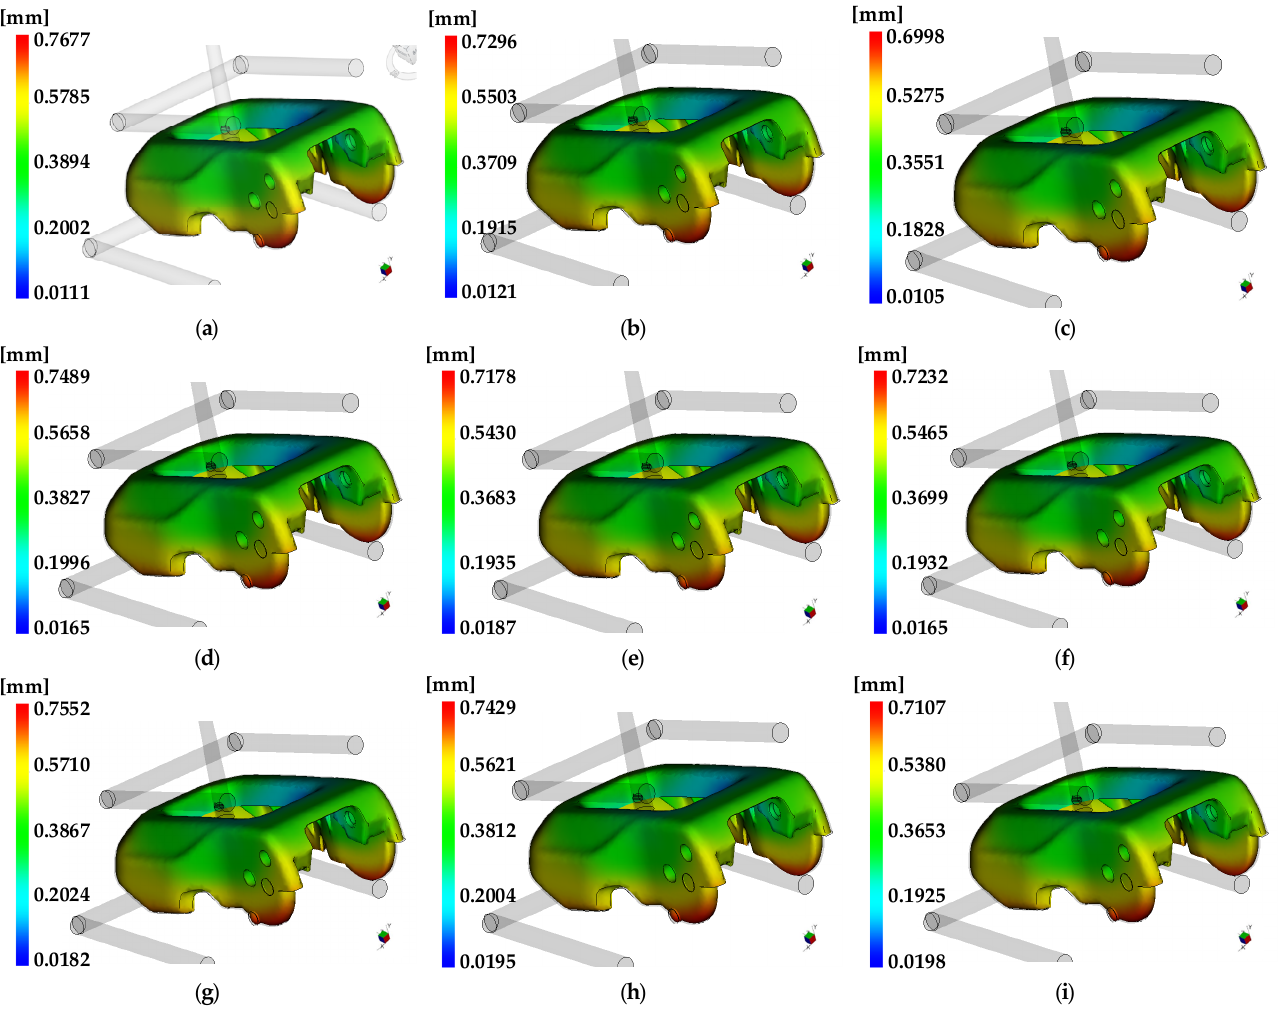
Figure 9. Deflection for the open lever. ( a ) Case 1. ( b ) Case 2. ( c ) Case 3. ( d ) Case 4. ( e ) Case 5. ( f ) Case 6. ( g ) Case 7. ( h ) Case 8. ( i ) Case 9.